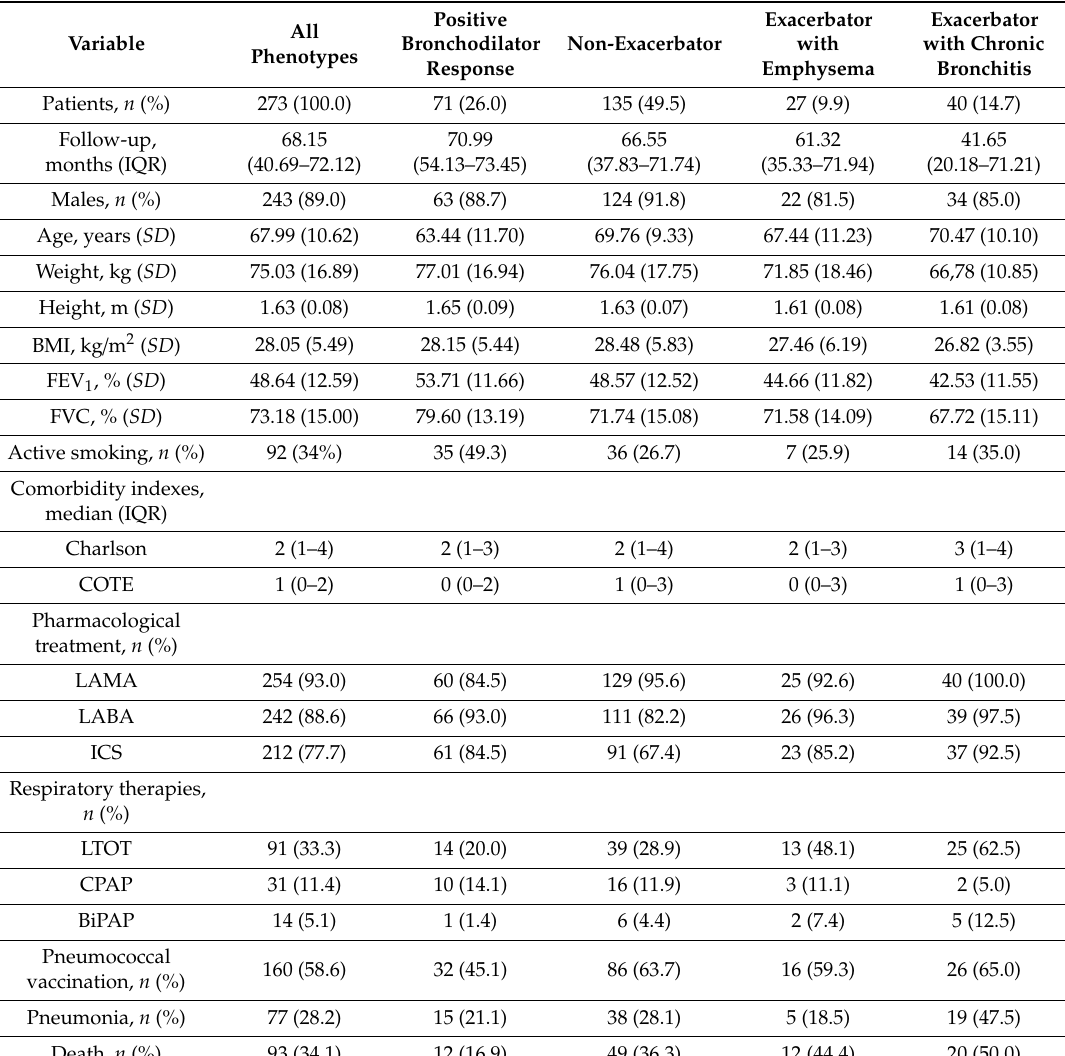
Table 1. General characteristics of the studied patients.